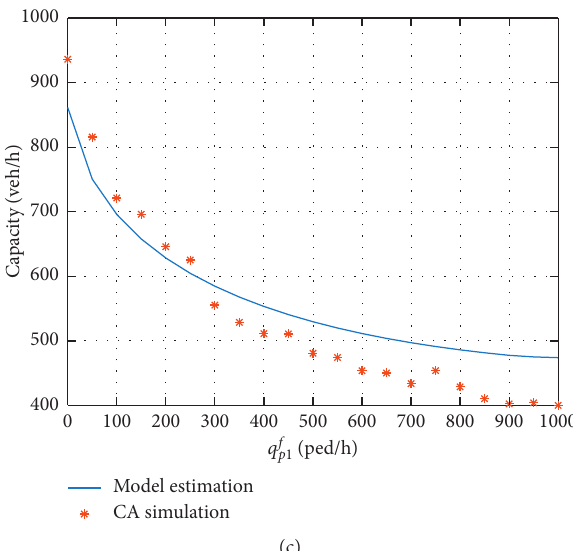
Figure 9: A comparison between microscopic simulation and model estimation. (a) P 1